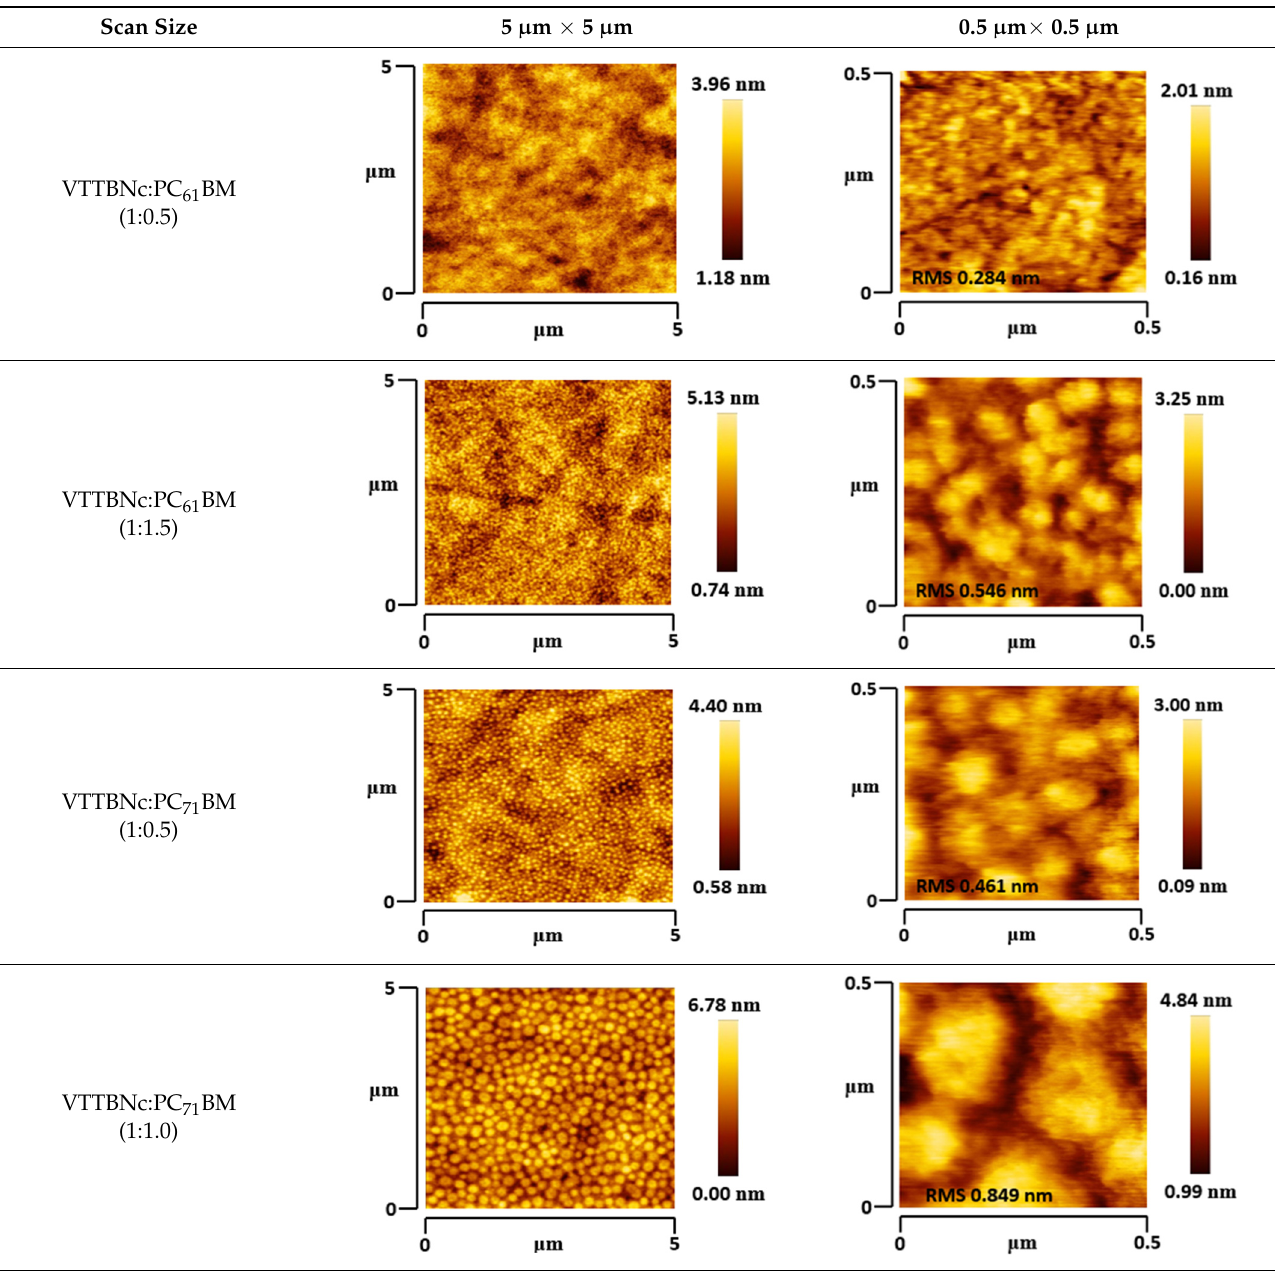
Table 5. Atomic Force Microscopy (AFM) images of VTTBNc:PC 61 BM (1:0.5 and 1:1.5) and VTTBNc:PC 71 BM (1:0.5 and 1:1.0).